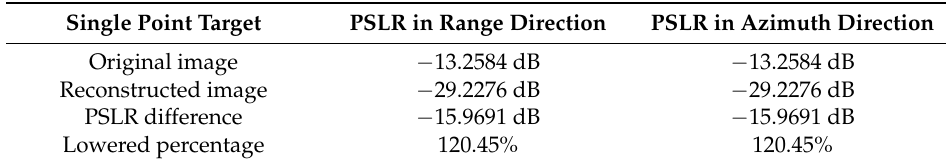
Table 1. PSLR of the original image and reconstructed image in range and azimuth directions.